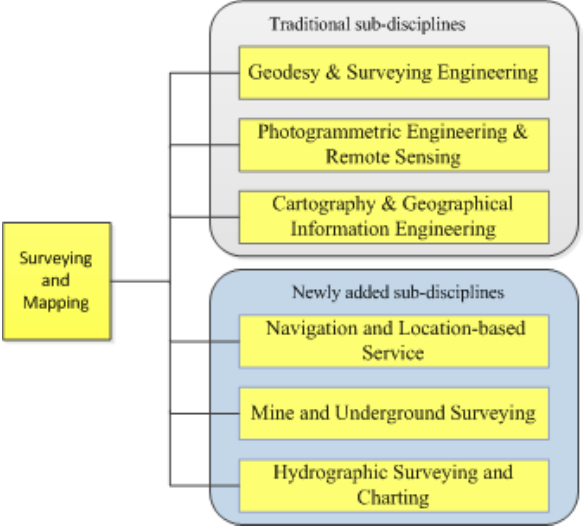
Figure 2. Updated sub-disciplines of Surveying and